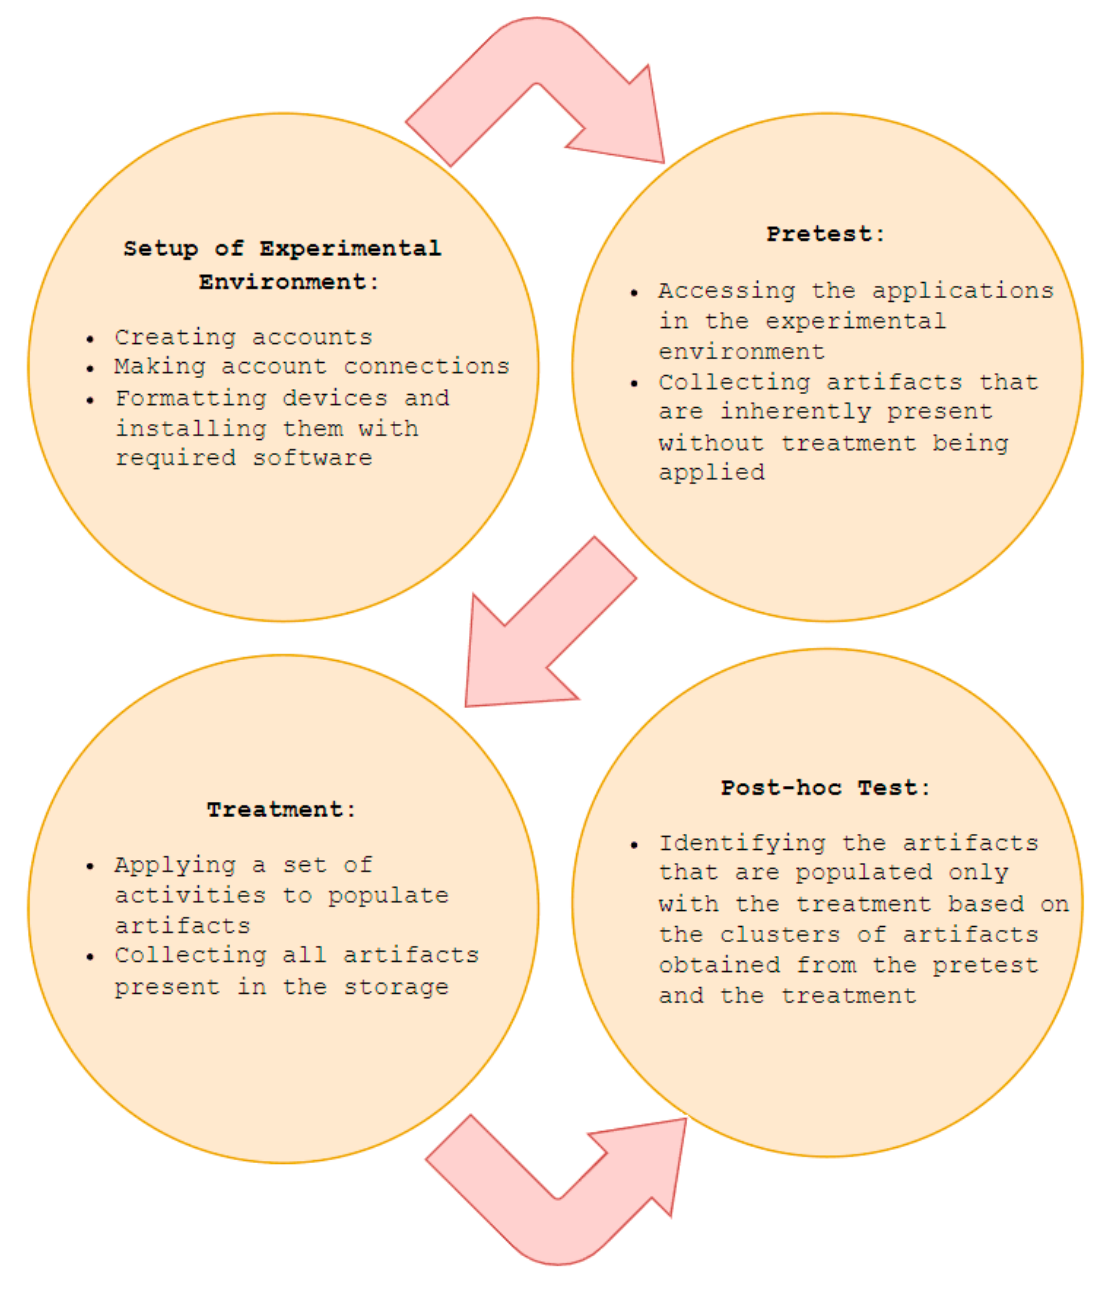
Figure 1. Experimental